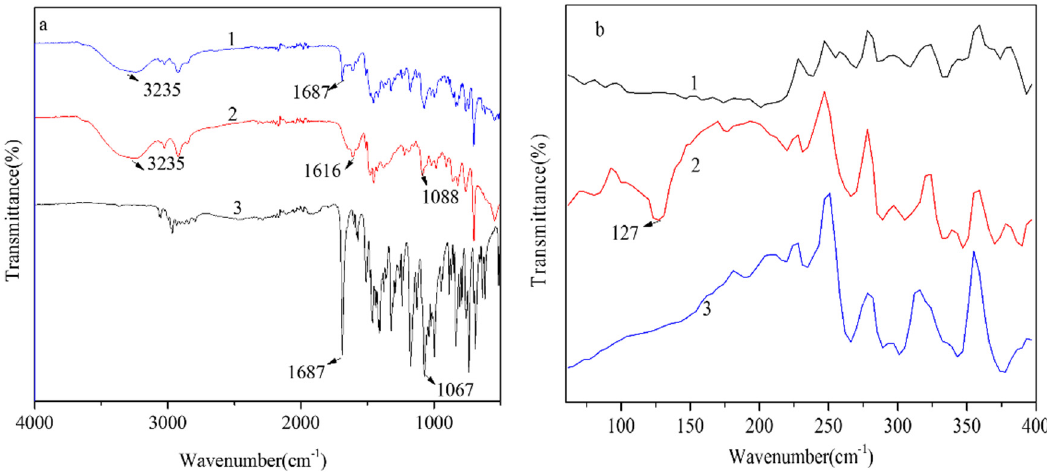
Figure 5. Mid − IR spectra ( a ) and Far − IR spectra ( b ) of the immobilized − HBA (1), immobilized − HBA-arbidol (2), and arbidol (3).